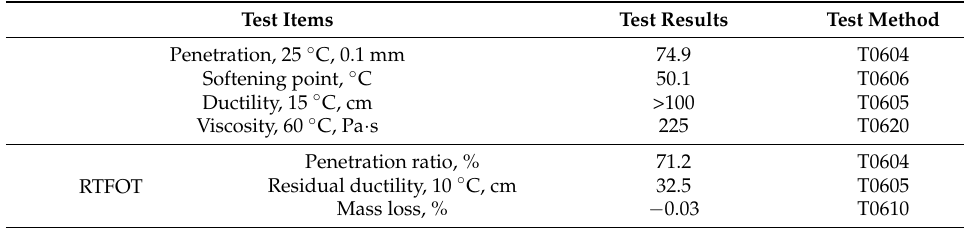
Table 1. Performance indexes of #70 virgin asphalt.